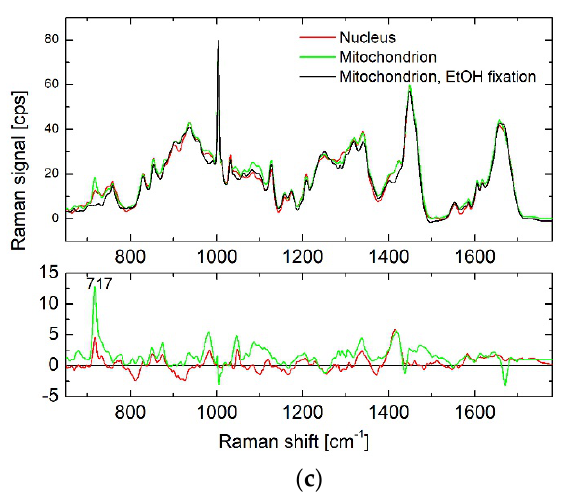
Figure 2. Raman profiles of the protein component - for different organelles (upper curves) and difference spectra (lower curves), obtained by subtraction of the nucleolar profile from that of other organelles, shown in upper part of the graph. Proteins components of nucleoli, mitotic cytoplasm and chromosomes for live cells are shown in ( a ), proteins components of nucleoli, nuclei and mitochondria for live cells are shown in ( b ), and proteins components of nuclei and in live cells and mitochondria in ethanol-fixed cells are shown in ( c ).